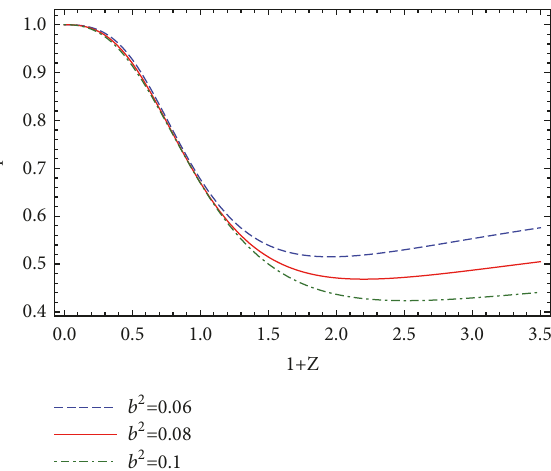
Figure 12: The evolution of the deceleration parameter 𝑞 versus redshift parameter 𝑧 for interacting GDE in the DGP model. Here, we have taken Ω 𝐷 (𝑧 = 0) = 0.73 , 𝐻(𝑧 = 0) = 67 , and Ω 𝑟